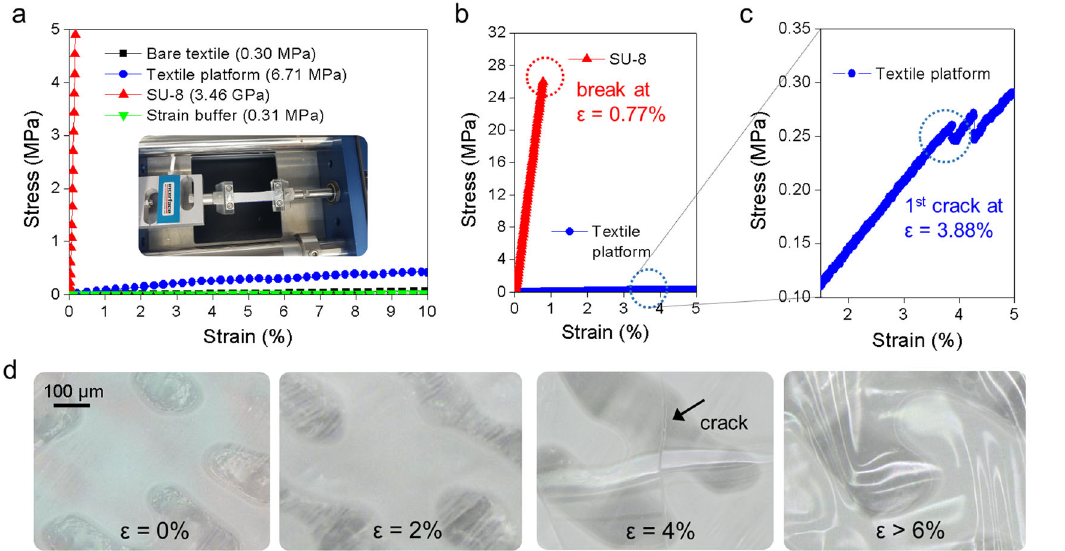
Fig. 2 Tensile tests of the textile platform. a The mechanical stress along the strain within the textile platform and each layer, calculated from the tensile test results. b Comparison of the mechanical stress between the single SU-8 layer and the textile platform. c Expanding the strain – stress graph of the textile platform. d Optical microscopy images of the textile platform after tensile testing at strains of 0%, 2%, 4%, and more than